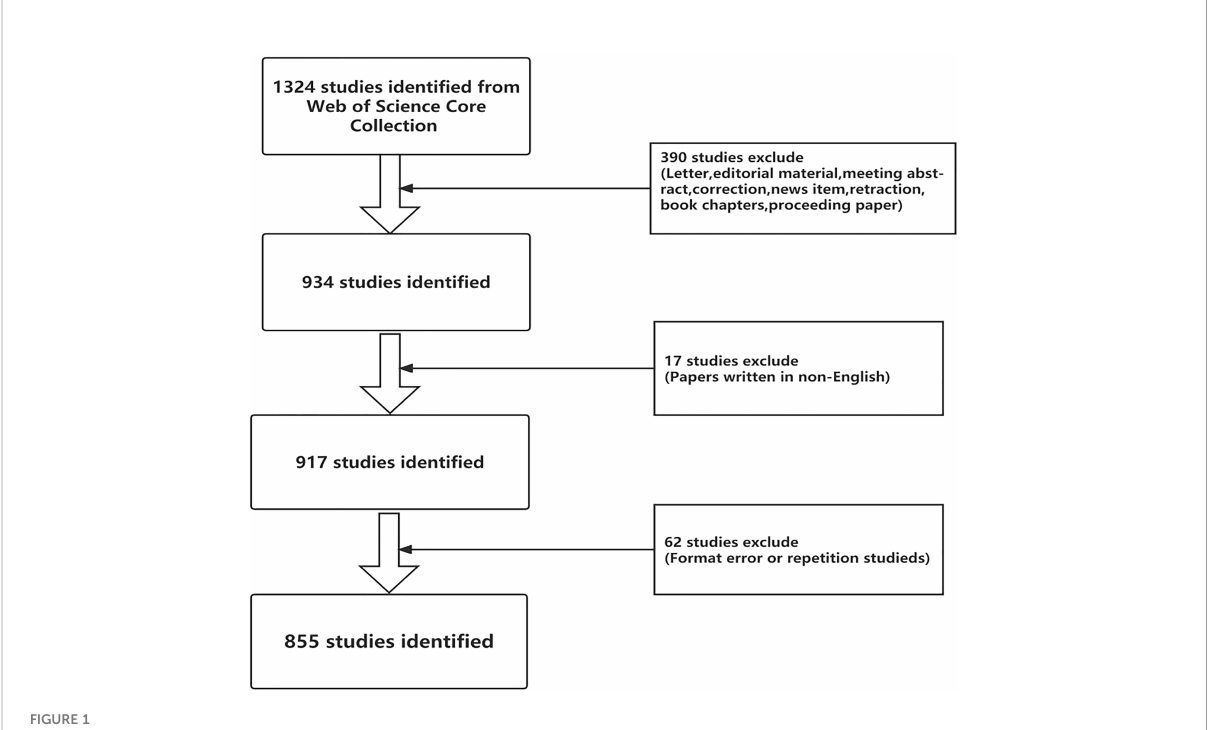
FIGURE 1 Detailed fl owchart of search, screening on the Web of